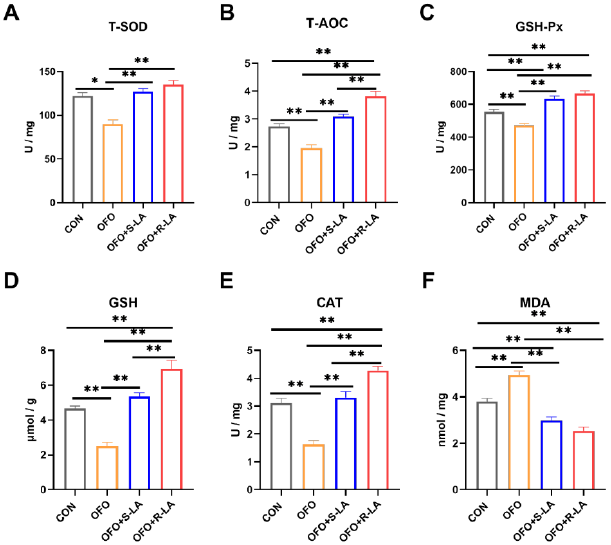
Figure 7. Effect of different treatments on oviduct antioxidant of laying hens. ( A ) Total superoxide dismutase (T-SOD); ( B ) total antioxidant capacity (T-AOC); ( C ) glutathione peroxidase (GSH-Px); ( D ) glutathione (GSH); ( E ) catalase (CAT); ( F ) malondialdehyde (MDA). * Indicates minimum significant differences ( p < 0.05), and ** indicates highly significant differences ( p < 0.01).